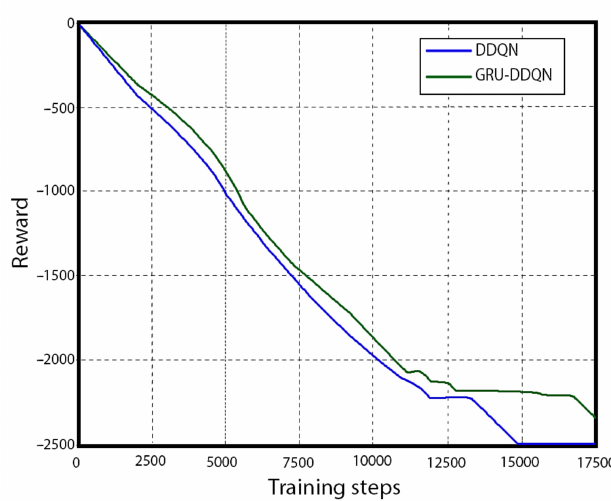
Figure 13. Q value comparison of different approaches.